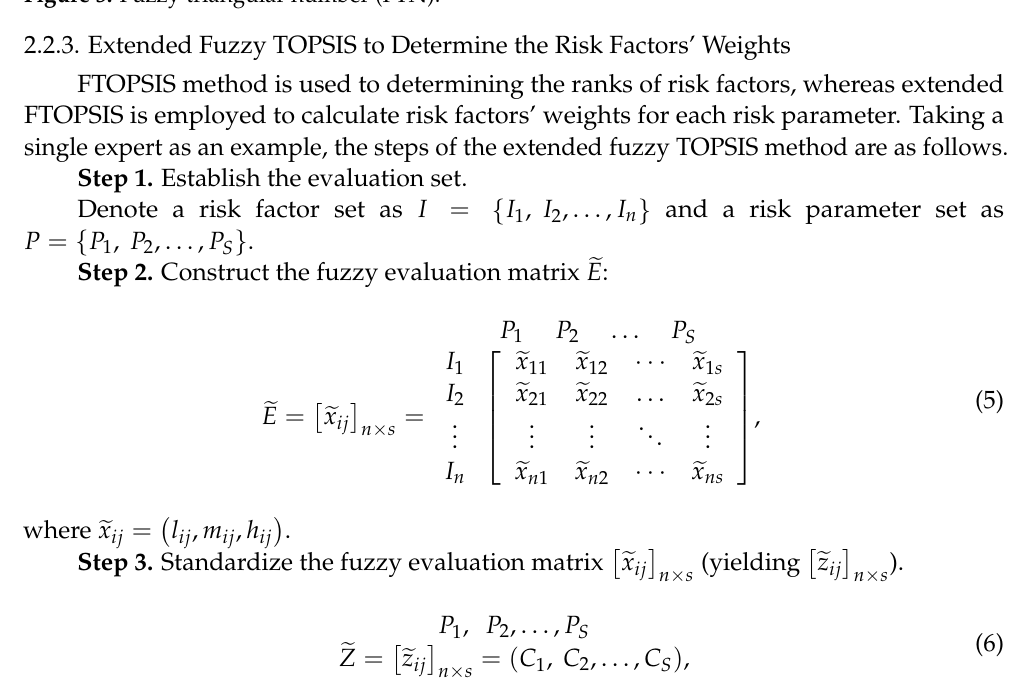
Figure 3. Fuzzy triangular number